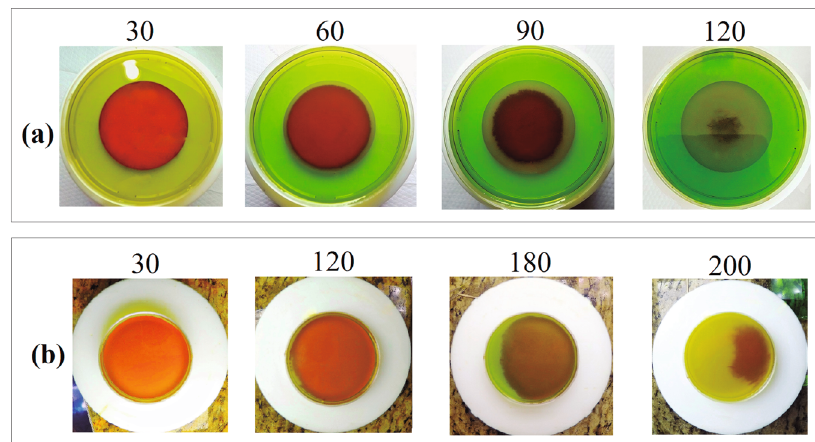
Fig. 2 Corrosion of CCL disc in the absence of magnetic fi eld. a Pictures of the typical corrosion process that happens on CCL disc in FeCl 3 solution at 30, 60, 90, and 120 min in a big cell (BC). b Pictures of CCL disc in FeCl 3 solution at 30, 120, 180, and 200 min in small cell